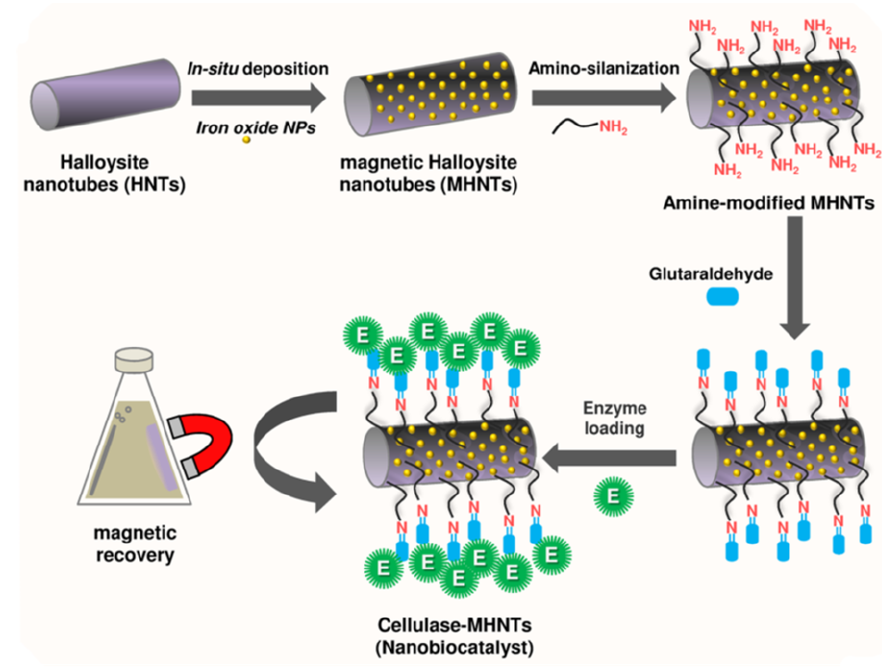
Figure 9. Schematic representation of the synthesis of cellulase-MHNTs (magnetic HNTs). Reproduced with permission from [121].